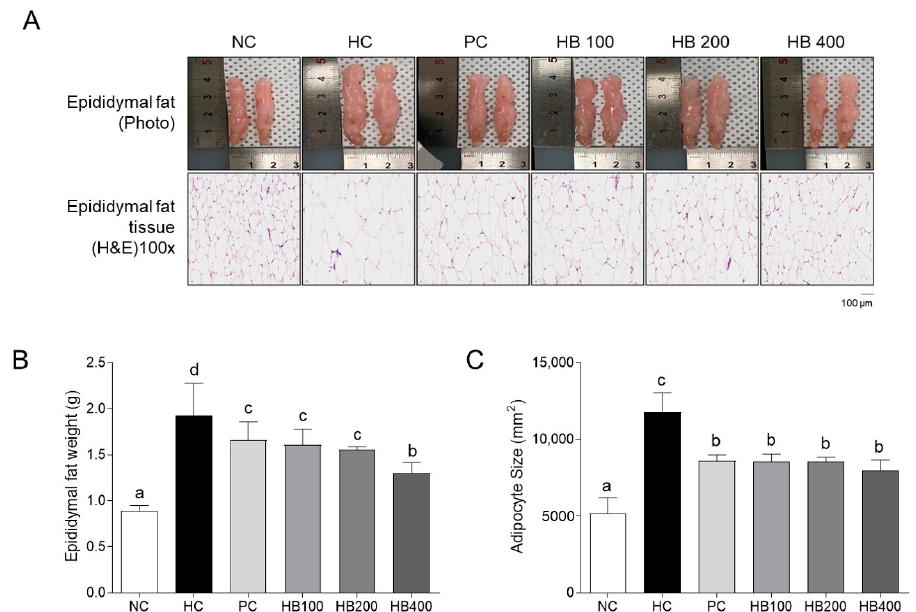
Figure 2. Effects of HB on the epididymal fat weight and adipocyte size in HFD-fed mice. ( A ) Photography of epididymal fat and hematoxylin and eosin (H&E) staining of epididymal fat tissue; ( B ) epididymal fat weight; and ( C ) average adipocyte cell size. All data are mean ± SD. Significant differences among six groups are expressed as different letters based on one-way ANOVA ( p < 0.05), followed by Duncan’s multiple range tests.